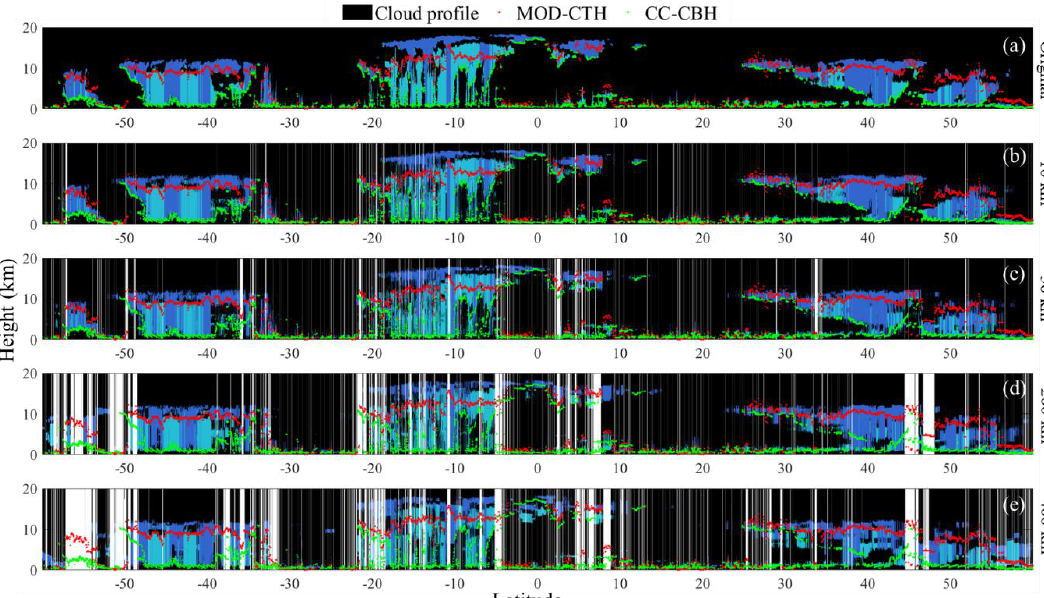
Figure 2. Reconstruction of the cloud profile measured by CloudSat on 16 January 2009 from 60 ◦ N to 60 ◦ S. The original profile is shown in panel ( a ). The dead zones were set to 10 km ( b ), 50 km ( c ), 200 km ( d ), and 400 km ( e ). The red dots indicate the original cloud top height (CTH) from MODIS, while the green dots indicate the original cloud base height (CBH) from the active sensor.